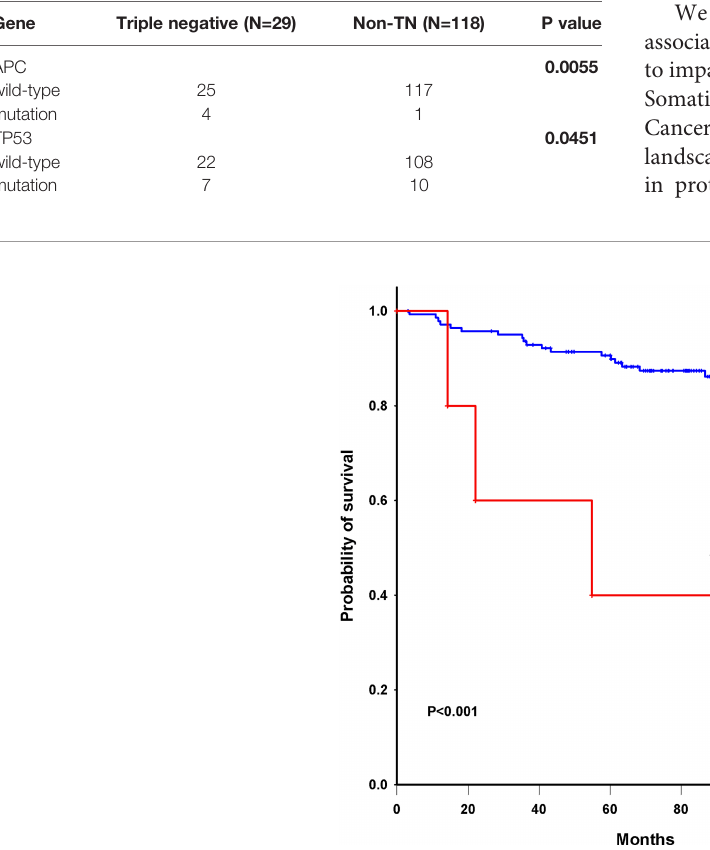
TABLE 3 | Evaluating associations between gene mutation status and triple- negative breast cancer patients by Fisher ’ s exact test.